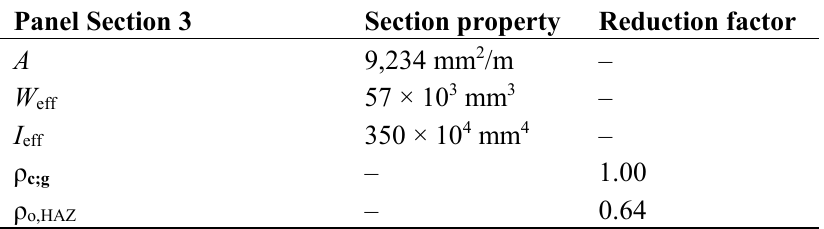
Table 7. Section properties of optimized Panel Section 3 (see Figure